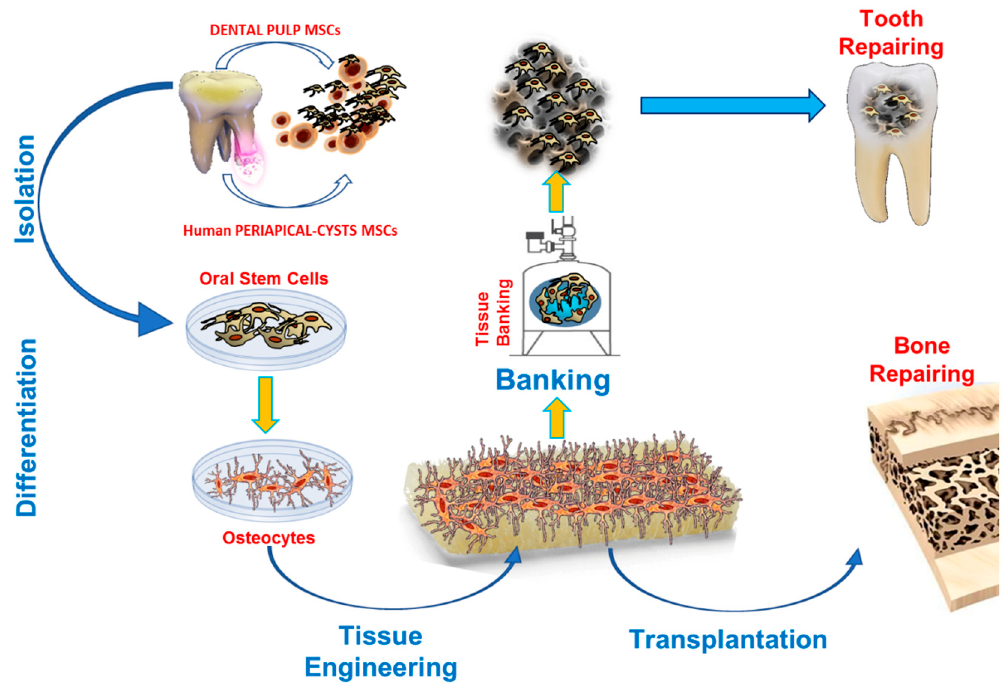
Figure 1. Workflow of the main tasks in the ODSCs processing for regenerative medicine purposes.